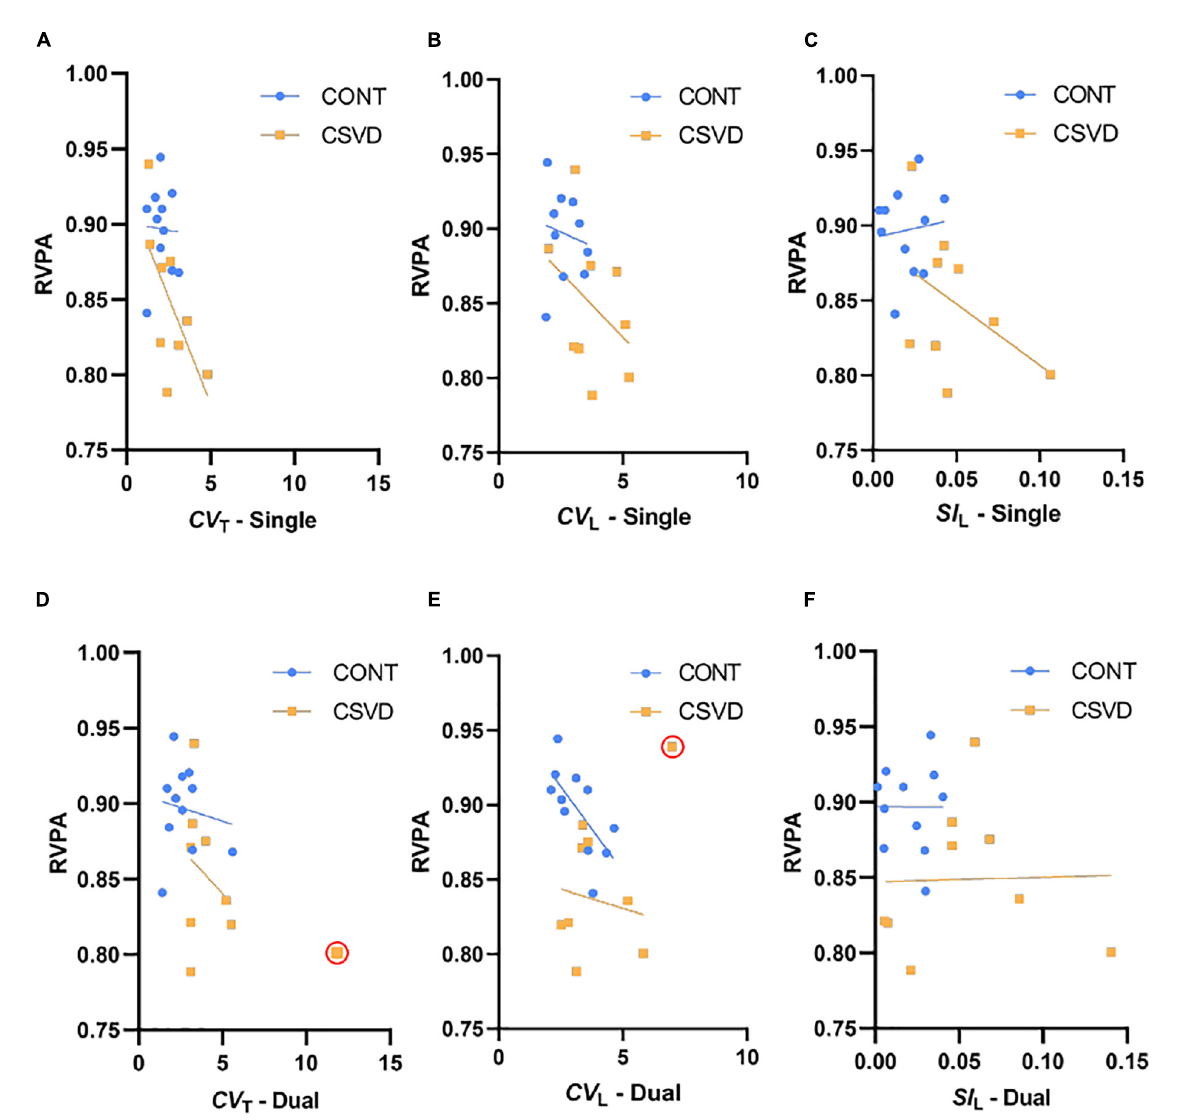
FIGURE6 Relationship between gait parameters and Rapid Visual Processing and Attention (RVPA) score. RVPA scores are plotted as a function of Step Time Coefficient of Variation [ CV T , panels (A,D) ], Step Length Coefficient of Variation [ CV L , panels (B,E) ] and Step Length Symmetry [ SI L , panels (C,F) ]. Data of patients with cerebral small vessel disease (CSVD, n = 9) are shown as orange squares while those of age- and sex-matched control participants (CONT, n = 11) are shown as light blue circles. Top and bottom panels display gait parameters during single and dual task conditions, respectively, outlier values are denoted by red circle. Trendlines are displayed for each group separately with the corresponding color. Please note that CSVD patients with higher Step Time Coefficient of Variation ( CV T ) during single task condition had a lower RVPA score compared to age- and sex-matched controls: Pearson’s r = –0.652 and p = 0.057 in CSVD group compared to Pearson’s r = –0.030 and p = 0.909 in CONT group. Such pattern is also visible for the other gait parameters particularly during single task condition but not in dual task condition, however the impact of the continuous predictor and CSVD were neither significant in any of these